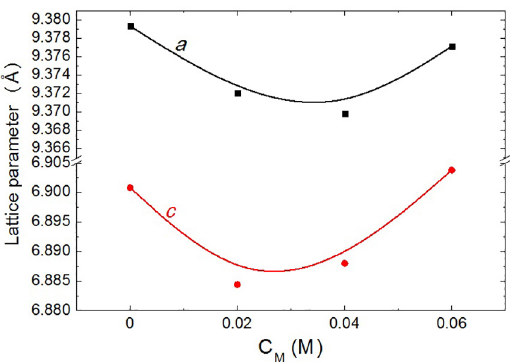
Figure 11. Hydroxyapatite lattice parameters in samples produced . by PEO with various C M to 50% of Mg-containing HA. Results of Rietveld refinement have shown the decrease of the lattice parameters a and c of HA crystalline structures in coatings produced in solutions with C = 0.02 and 0.04 M. Such characteristics suggest M the replacement of Ca by Mg ions in the HA structure, confirming the production of Mg-doped HA. The treatment with the electrolyte containing 0.06 M MgA was effective in producing HA with a crystalline structure similar to that of HA produced with C = 0.0 M. In that case, the coating M produced contained around 17% of magnesium